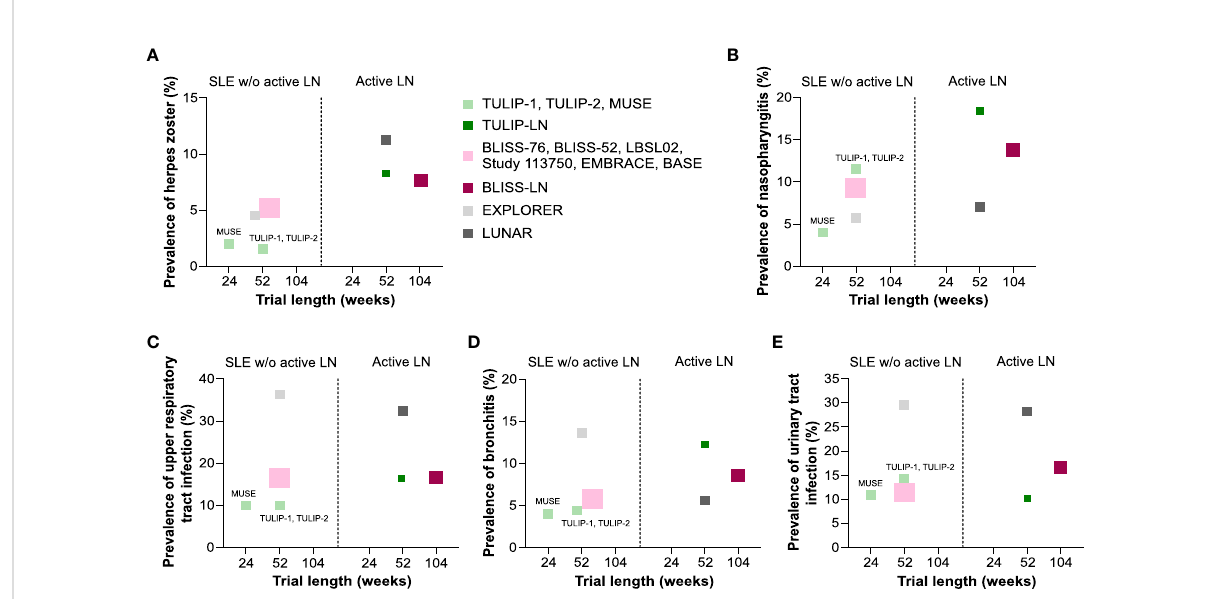
FIGURE 3 Comparison of infectious complications in standard of care placebo group between SLE without versus with active LN trials. (A – E) Comparison of the prevalence of herpes zoster (A) , nasopharyngitis (B) , upper respiratory tract infection (C) , bronchitis (D) , and urinary tract infection (E) in patients receiving placebo in the systemic lupus erythematosus (SLE) without active lupus nephritis (LN) trials that are reported for the anifrolumab (TULIP-1, TULIP-2, MUSE), belimumab (BLISS-76, BLISS-52, LBSL02, Study 113750, EMBRACE, BASE) and rituximab (EXPLORER) trials and in the active LN trials that are reported in the anifrolumab (TULIP-LN), belimumab (BLISS-LN) and rituximab (LUNAR) trials in correlation to the trial length (weeks). W/o,